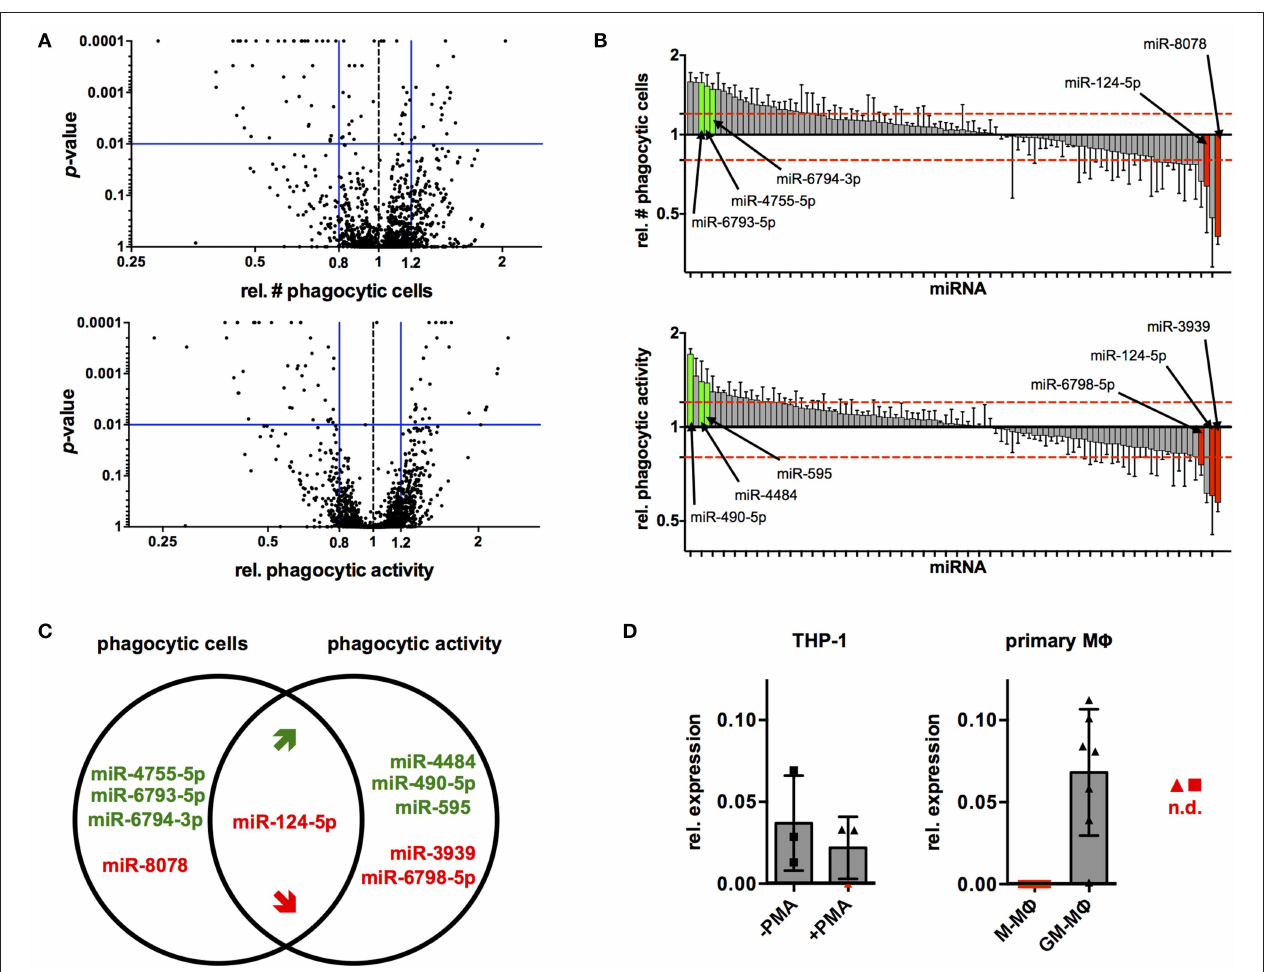
FIGURE 3 | High-content screening identifies several miRNAs that alter phagocytic behavior of PMA-activated THP-1 M 8 . (A) Volcano plots of p -value over relative number (rel. #) of phagocytic cells (left panel) or relative phagocytic activity (right panel) for cells transfected with all miRNAs tested in the primary screen. Blue bars represent cutoff values for change of relative number or phagocytic activity ( ≤ 0.8 or ≥ 1.2) and significance ( p ≤ 0.01). (B) Bar charts of rel. # of phagocytic cells (upper panel) or relative phagocytic activity (lower panel) of cells transfected with the 95 miRNAs tested in the secondary screen. Values for each miRNA are the mean ± standard deviation (SD) of triplicate measurements indicated by a bar and whiskers and were ranked according to the extent of the effect (rel. fold-change). Bars of miRNAs that met the selection criteria in both screens are labeled in green (increase) or red (decrease), and the names of the corresponding miRNAs have been connected to the bars with an arrow. For visualization of the data across all plates of the primary or secondary screen, values were normalized to the mean of the on-plate NT controls. Statistical analysis was performed on raw data of the triplicate measurements on each plate using one-way ANOVA. Dunnett’s post analysis was used to calculate p -values adjusted for multiple comparisons with the NT set as control condition. (C) Venn diagram of the 10 miRNAs that robustly and reproducibly altered the number of phagocytic cells and/or phagocytic activity in the primary and secondary screen. MiRNAs that enhance phagocytosis are labeled in green, and those that reduce phagocytosis are labeled in red. (D) Levels of miR-124-5p transcripts in THP-1 Mo (–PMA) and M 8 ( + PMA) or ex vivo differentiated M- and GM-Mq as assessed by qRT-PCR ( n = 3 for THP-1 cells and n = 7 donors for primary cells). Symbols for samples with miR-124-5p levels below the detection limit (n.d.) are marked with red